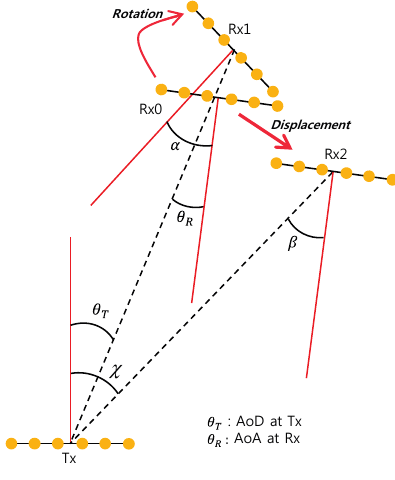
Figure 1. Variation in angle of departure (AoD) and angle of arrival (AoA) due to behavioral change in a mobile station (MS).